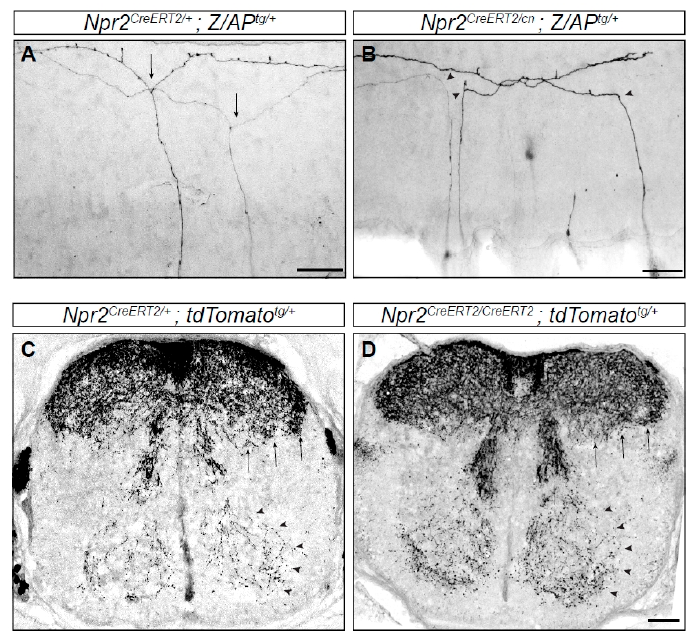
Figure 3. Branching errors of primary sensory neurons in the spinal cord. Individual axons are labeled by a genetic sparse labeling method. ( A ) Two DRG axons from a Npr2 heterozygous mouse show T-shaped branches (arrows) at the DREZ of the spinal cord. ( B ) In homozygous Npr2 mutants DRG axons turn in rostral or caudal direction but do not bifurcate (arrow heads). ( C , D ) Collaterals are formed in the absence of Npr2 ( D ) as in heterozygotes ( C ) shown in cross sections of the E17.5 spinal cord using a reporter mouse line encoding red fluorescent protein which is activated by tamoxifen injections via Npr2-CreERT2 (causes recombination estrogen ligand-binding domain). Therefore, only Npr2-positive sensory neurons and their axons and collaterals are labeled. However, since the recombination efficiency varies from embryo to embryo due to the variable uptake of tamoxifen and due to the presence of two Npr2-CreERT2 alleles in the Npr2 knockout no quantitative conclusions on the amount of collaterals can been drawn from ( C , D ). Staining with antibodies to peripherin or TrkA (tropomyosin receptor kinase A) showed that in homozygous Npr2 mutants collaterals are reduced due to the bifurcation defect [43,45,46]. Arrows point to nociceptive collaterals of deep dorsal horn layers and arrow heads to proprioceptive collaterals. Scale bar in ( A , B ), 50 µm and in ( C , D ) 100 µm.